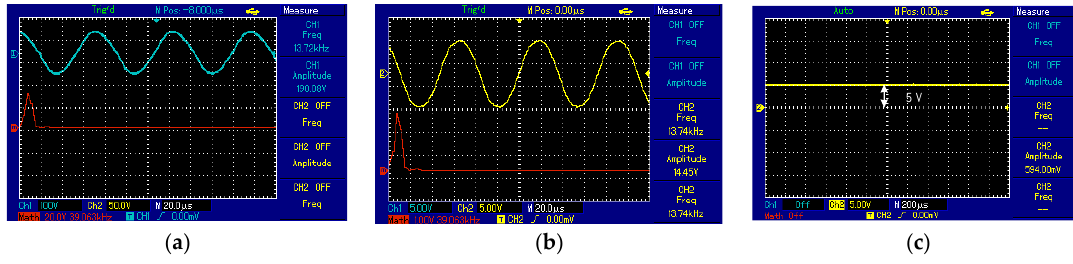
Figure 16. The voltage waveforms using the third topology at 20 cm for measurement unit: ( a ) transmitter coil, ( b ) receiver coil, and ( c ) voltage load.